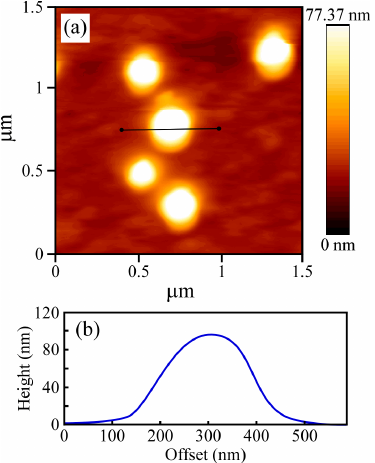
Figure 5. ( a ) Atomic force microscope (AFM) height image and ( b ) corresponding height cross-section for the PICsome with f + = 0.5.